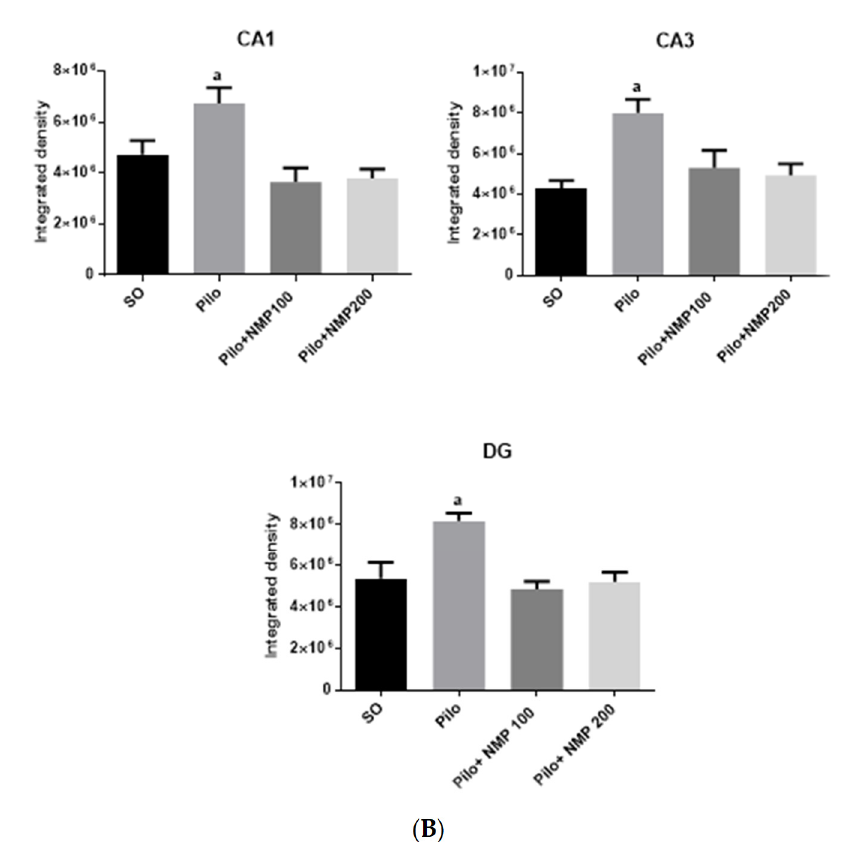
Figure 5. The N -methyl-(2S,4R)-trans-4-hydroxy- L -proline-rich fraction (NMP) completely prevented the increase in hippocampal glial fibrillary acidic protein (GFAP) immunoexpression in mice subjected to the intracerebroventricular (icv) injection of pilocarpine (Pilo). The animals received Pilo (300 µg/1 µL, icv) and, 24 h after, were treated with NMP (100 or 200 mg/kg, per os , po ), for 15 days. The sham-operated (SO) group received the vehicle, distilled water, po . After the behavioral tests, the animals were euthanized for immunofluorescence assays, performed with four animals per group. On the left, photomicrographs are presented for each group, in hippocampal fields showing cells stained for GFAP only (in red) and nuclei counterstained with 4 ′ ,6-diamidino-2-phenylindole (DAPI) (in blue) ( A ). Quantification (bars on the right) is referred to the fluorescence integrated density in the various hippocampal subfields ( B ). CA1: a. vs. SO, p < 0.0002; CA3: a. vs. SO, p < 0.0001; DG: a. vs. SO, p < 0.0001; (one-way analysis of variance and Dunnett’s test for multiple comparisons).